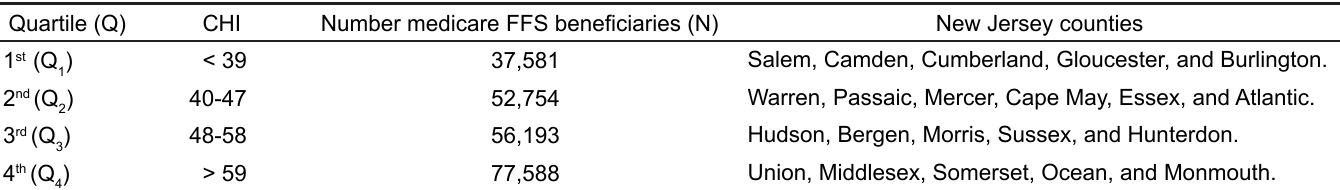
Table 1. Definition of county quartiles by Community Hardship Index (CHI).